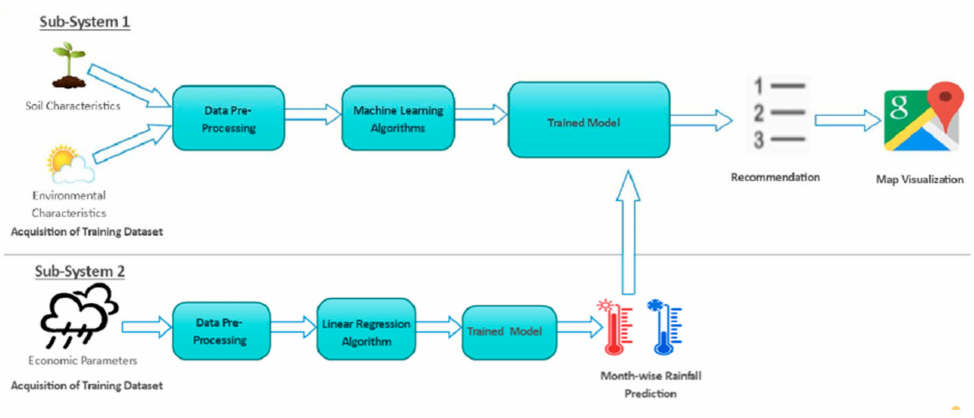
Figure 9. System architecture of AgroConsultant